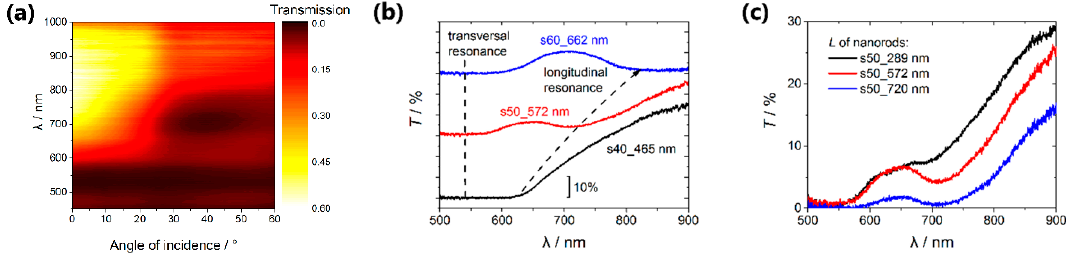
Figure 4. Angular-wavelength transmission spectrum of the sample s50_289 nm ( a ); transmission spectra of the samples with different volume fraction of metal ( b ) and with different nanorods lengths in the same template s50 ( c ). In all cases the incidence angle of 25° was used.